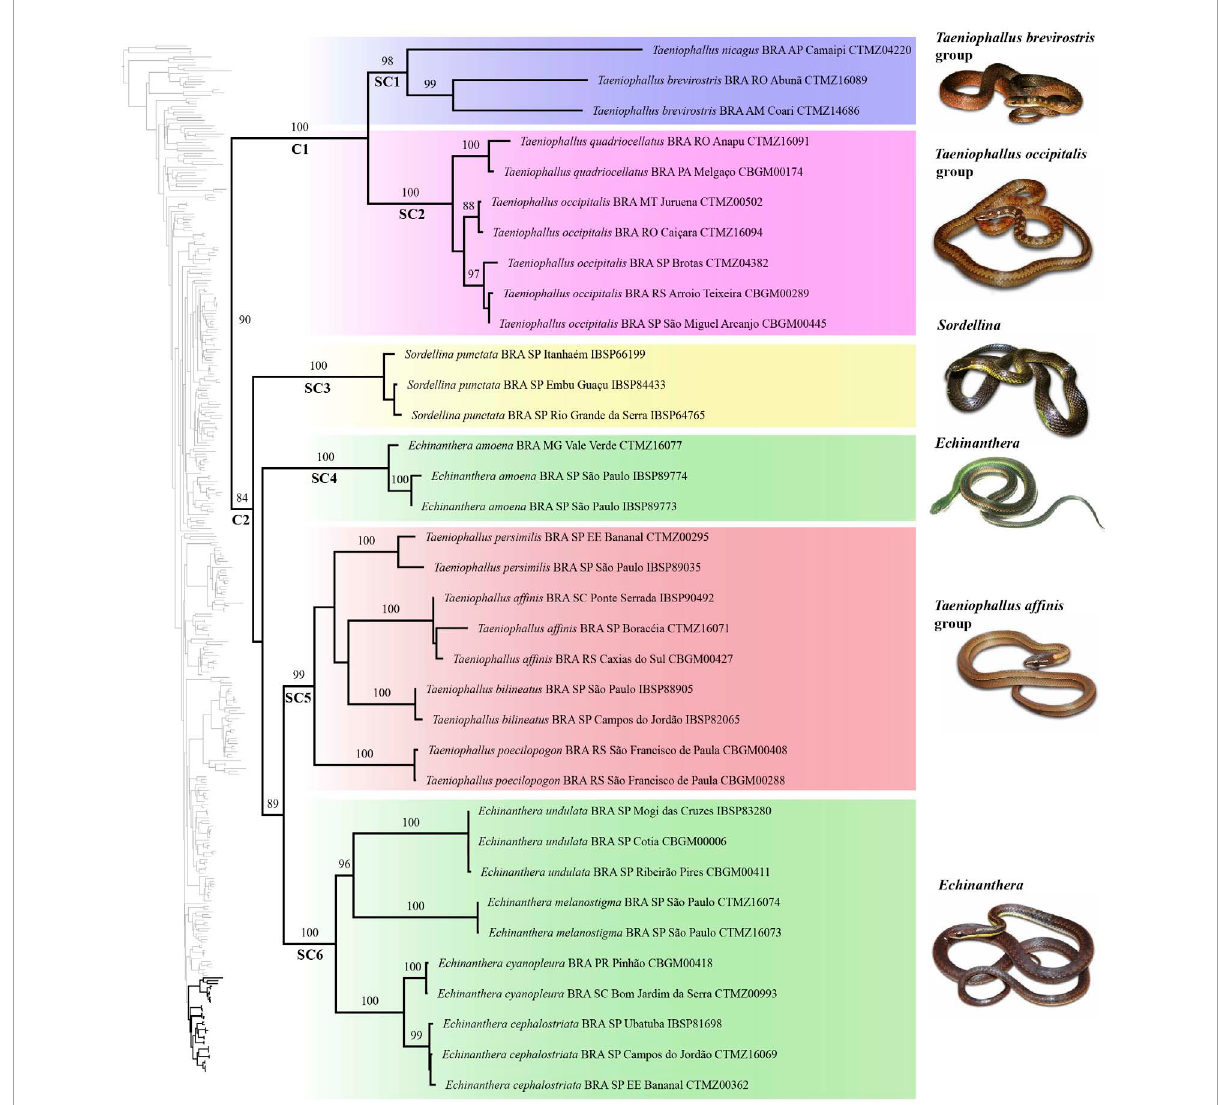
FIGURE2 Maximum likelihood tree based on the concatenated matrix (RAxML) of the tribe Echinantherini. Only bootstrap support values > 70 are shown for clarity. The topology of the complete ML tree is provided on the left; the clade highlighted in black corresponds to the tribe Echinantherini ( Supplementary Appendix 6